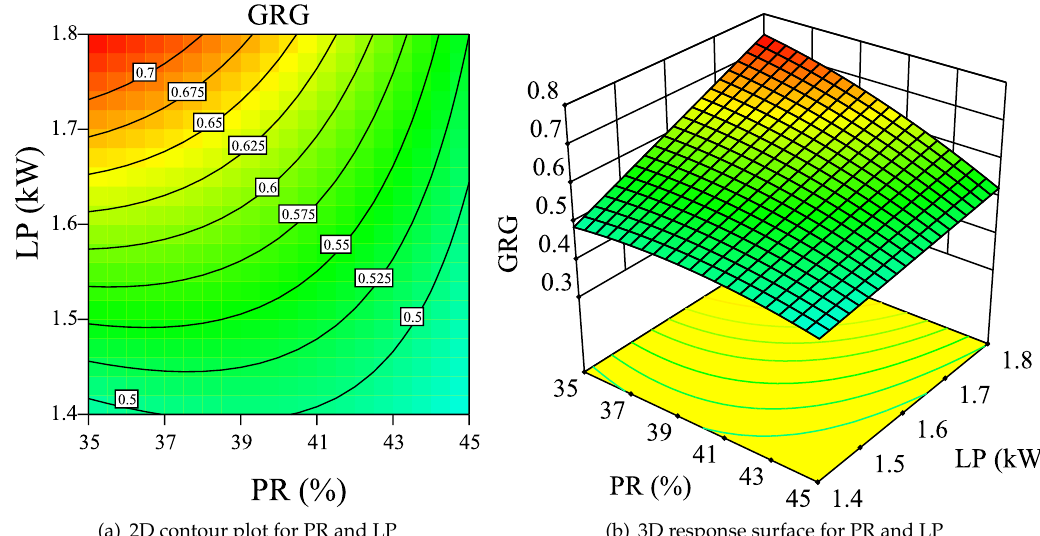
Figure 8. Response of GRG to PR and